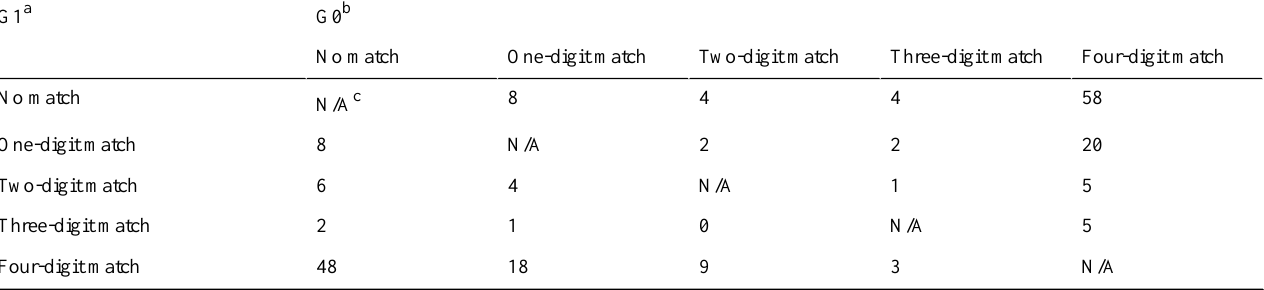
Table 5. Performance of Generation 1 compared with Generation